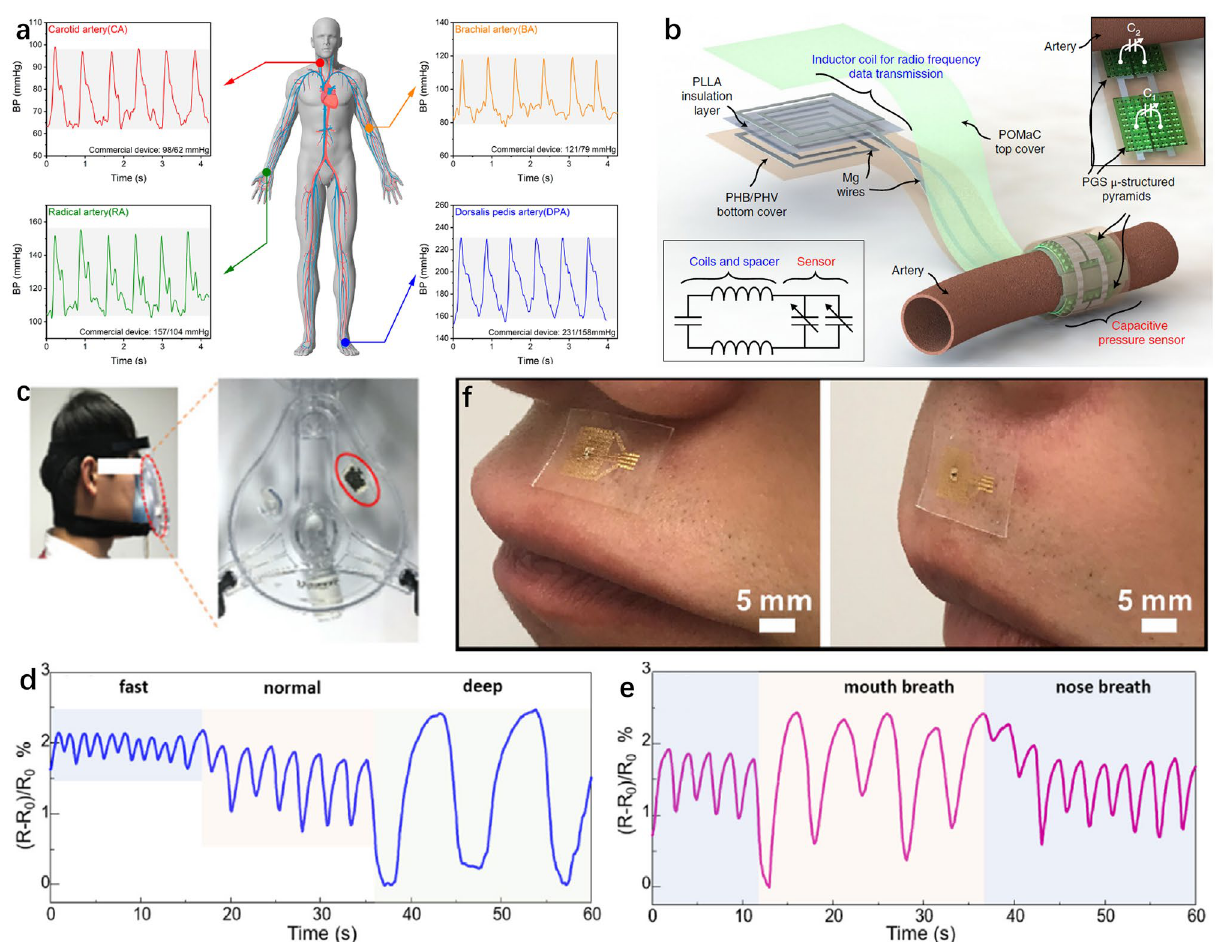
Fig. 8 Soft sensors for pulse and respiration. a Blood pressure waveforms and values collected at the CA, BA, RA, and DPA. Gray areas indi- cate the BP range between the SBP and DBP values detected by a commercial sphygmomanometer. Reproduced with permission [226]. Copy- right (2020), American Chemical Society. b Illustration of the pulse sensor with an exposed view of the bilayer coil structure for wireless data transmission and the cuff-type pulse sensor wrapped around the artery. Inset: Close-up view of the pressure-sensitive region of the sensor with the two variable capacitors C 1 and C 2 . The two variable capacitors correspond to C 1 and C 2 . The two inductors are in series with a fixed capaci- tor. Reproduced with permission [228]. Copyright (2019), Nature Publishing Group. c Photograph of a volunteer wearing the medical breath- ing mask with the humidity sensor fixed inside it. d Resistance variation response to fast, normal, and deep breathing. e Resistance variation response to mouth and nose breathing. Reproduced with permission [21]. Copyright (2018), Elsevier. f Photograph of the respiration sensor on the top of the upper lip with two motions, including pouting (left) and compressing lips (right). Reproduced with permission [237]. Copyright (2020),